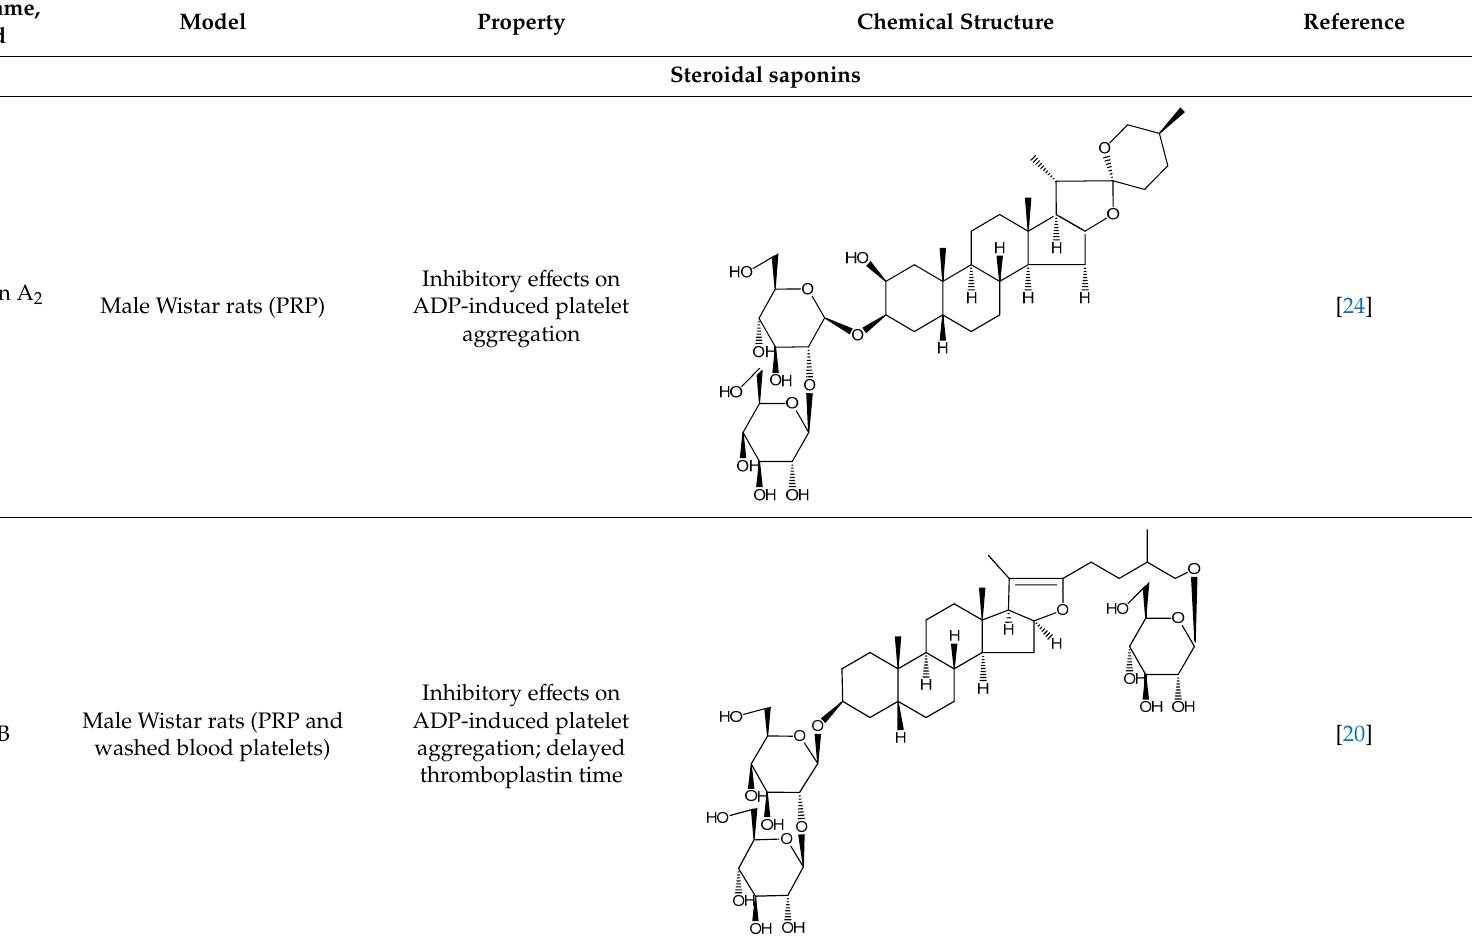
Table 1. Steroidal and triterpenoid saponins with antiplatelet and antithrombotic activity (in vitro and in vivo models).